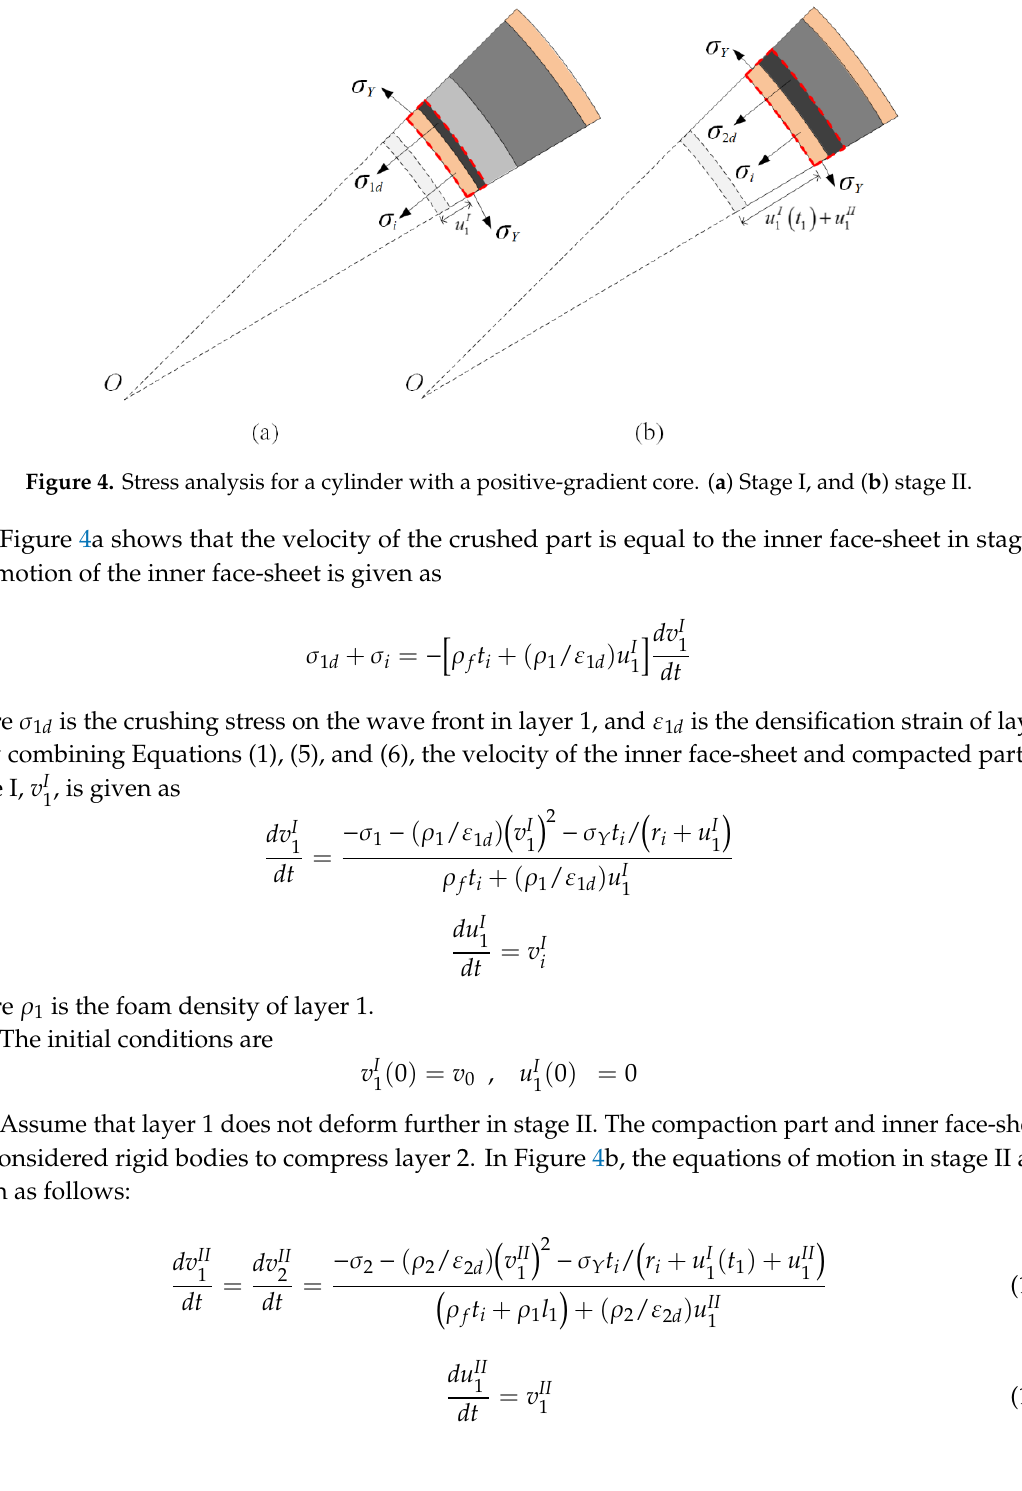
Figure 3. Response process of a cylinder with a positive-gradient core.